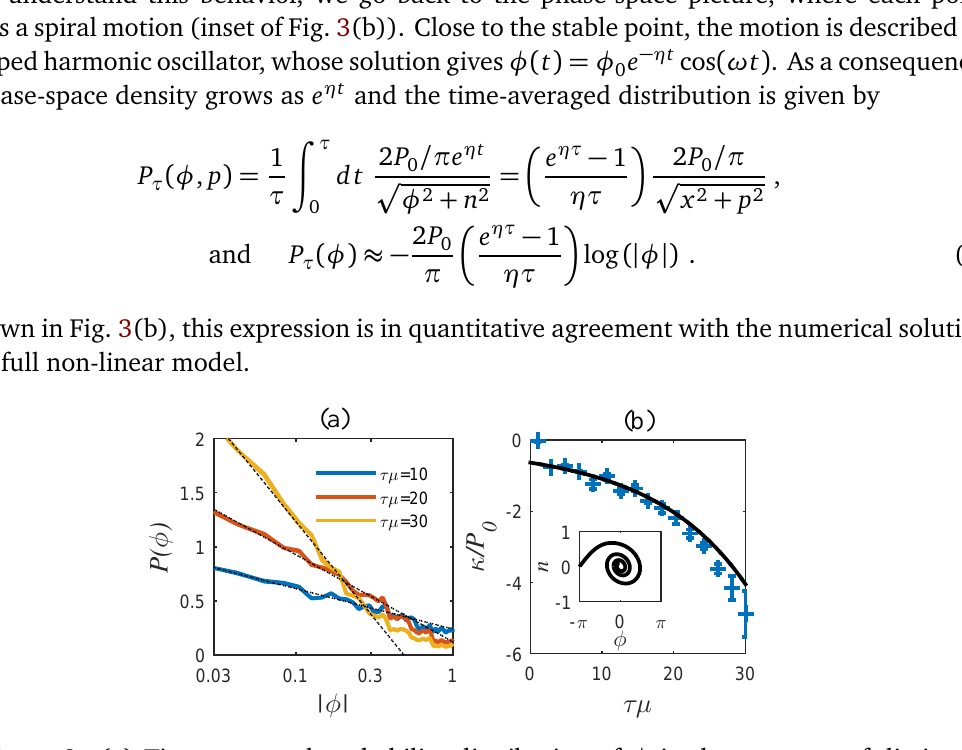
Figure 3: (a) Time-averaged probability distribution of φ in the presence of dissi- pation, for different waiting times τ . (b) Prefactor of the logarithm, obtained by a numerical fit of the form P τ ( φ ) = κ ( τ ) log ( | φ | ) (crosses) and by the analytical expression Eq.9 (black line). Inset: phase-space trajectory in the presence of dissipa-